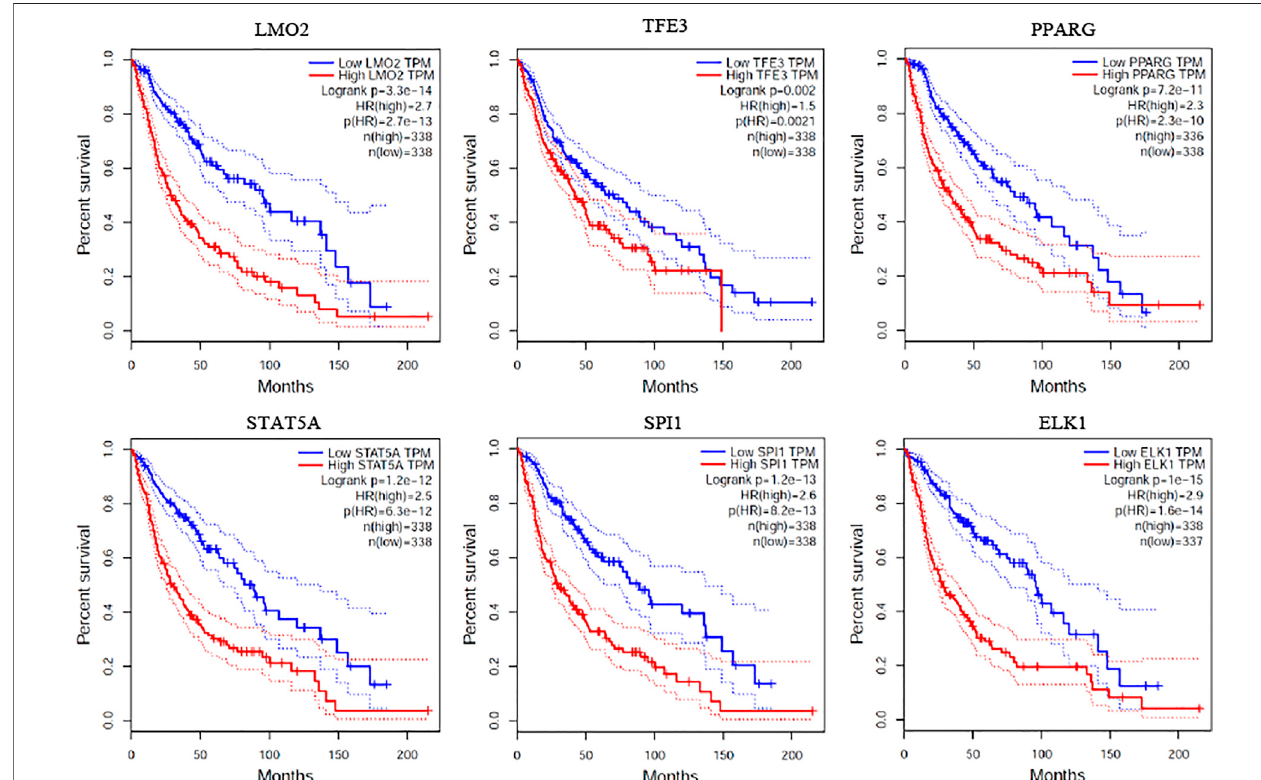
FIGURE 7 | Survival